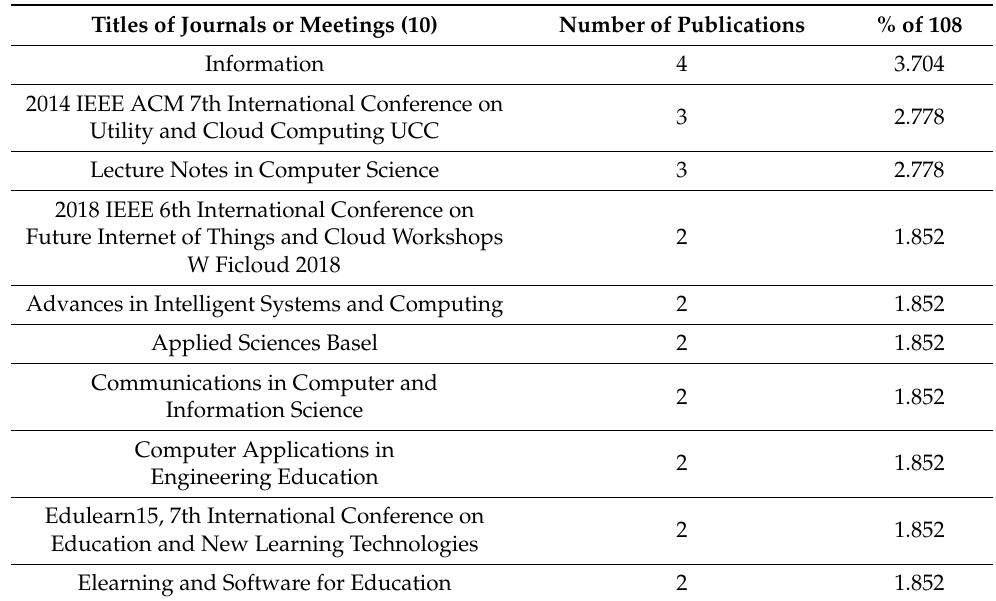
Table 4. Titles of Journals or